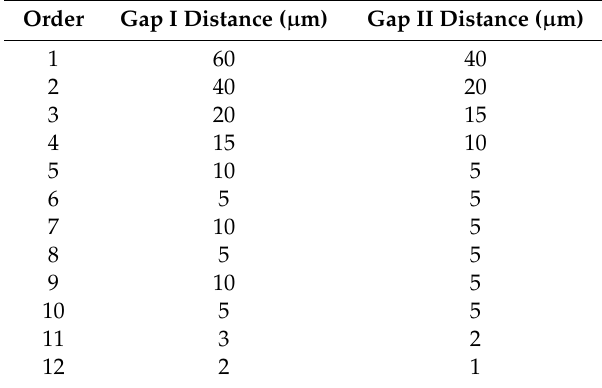
Figure 1. ( a ) Three-roll milling machine for dispersing CNM in the composites, and ( b ) a schematic diagram illustrating dispersion procedures implemented by three-roll milling machine. Table 2. Distance of Gaps I and II adjusted in each pouring and withdrawal cycle.